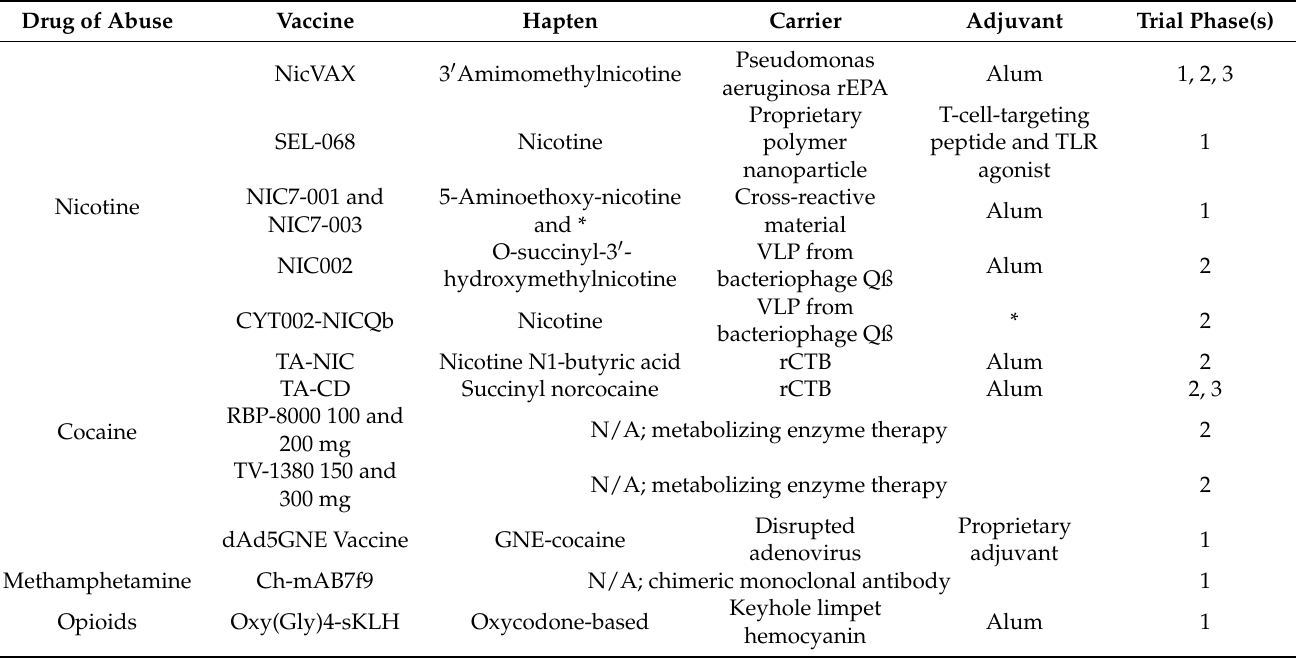
Table 2. Summary of studies for vaccines against nicotine abuse, cocaine, methamphetamines, and opioids